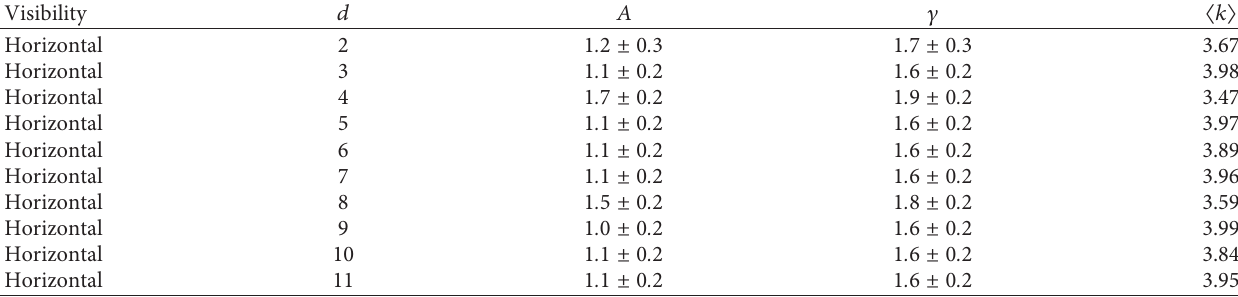
Table 5: Values of A and c of the fitted degree distribution P ( k ) � Ak − c and the average degree 〈 k 〉 in function of d for the horizontal visibility algorithm employed for mapping x d ( n ) into